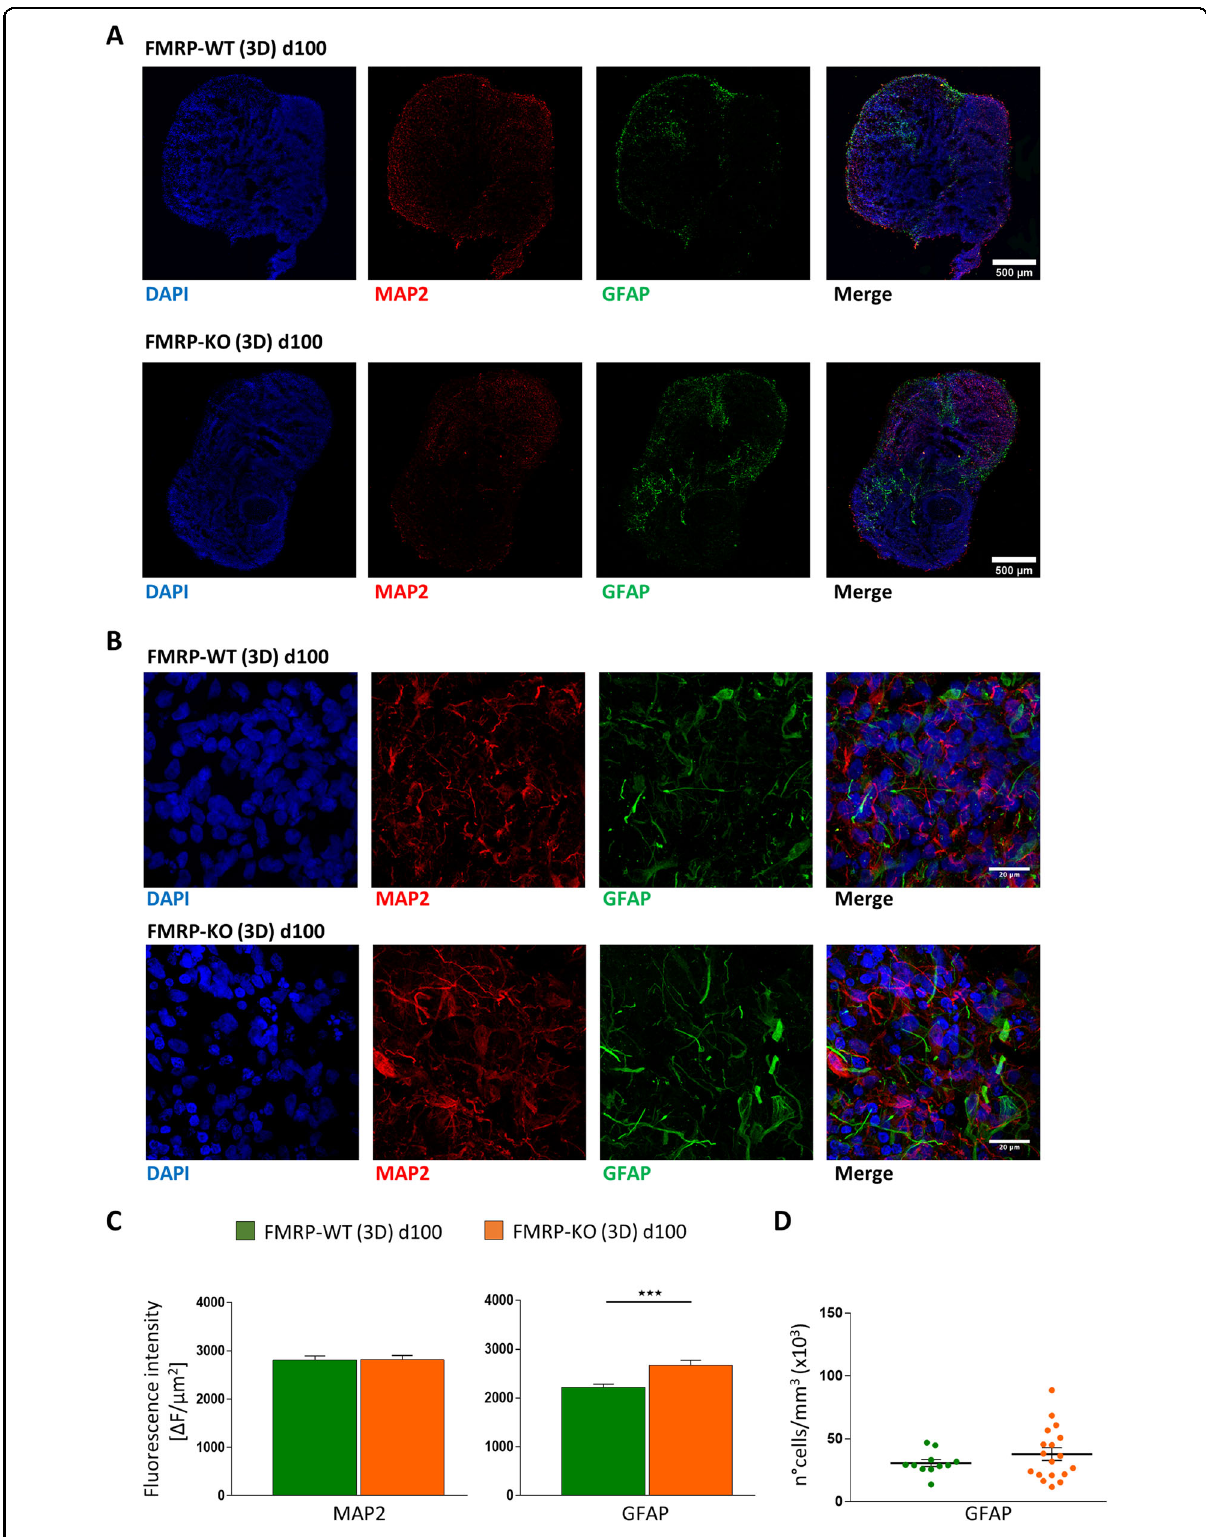
Fig. 9 (See legend on next